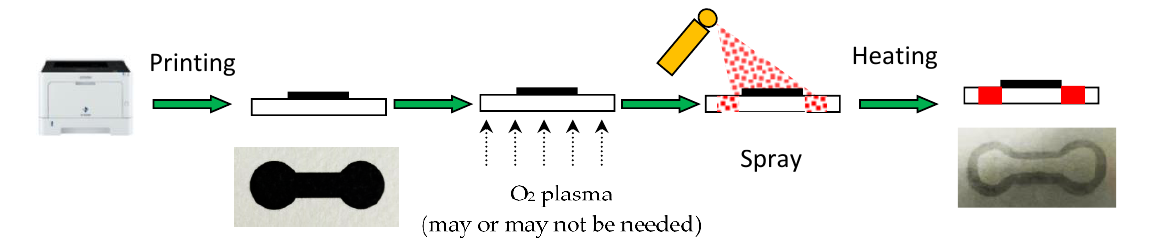
Figure 1. Schematics of spray on printed-paper process (not in scale).